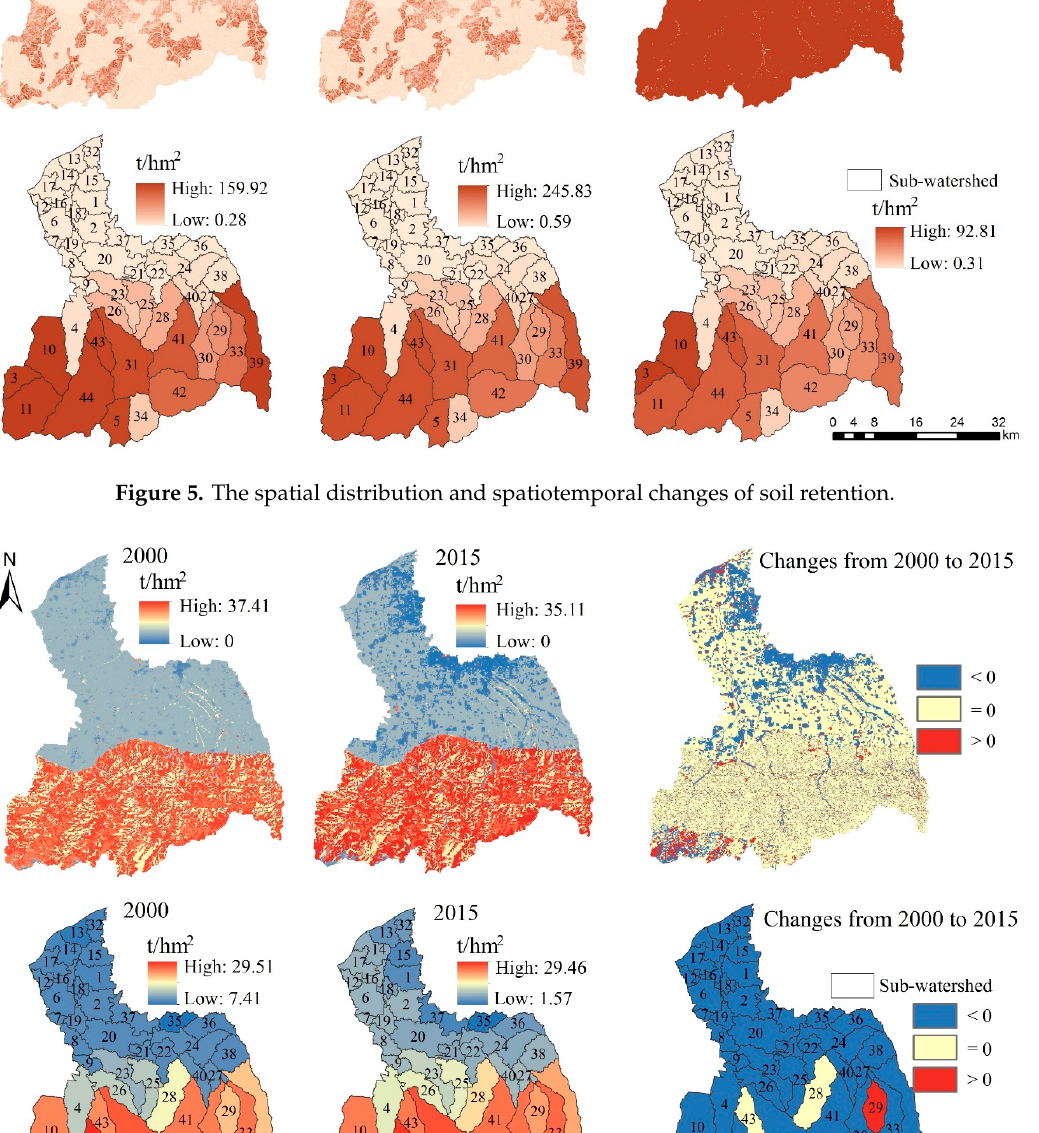
Figure 7. The spatial distribution and change of population in FRW in 2000 and 2015. 3.2.2. Food Demand From the grid scale, the high-value areas of food demand are mainly distributed in the midstream area and downstream area (Figure 8). Compared with 2000, the high-value areas of food demand in 2015 have increased, and the main increase areas are distributed close to the main urban area of Xi’an. From 2000 to 2015, the amount of food demand increased from 7.45 × 10 11 kcal to 10.38 × 10 11 kcal, an increase of 39.37% (Table A2). From the sub-watershed scale, the amount of food demand in sub-watersheds 1, 13, 14, 35, and 37 are higher, while it is lower in sub-watersheds 3, 5,